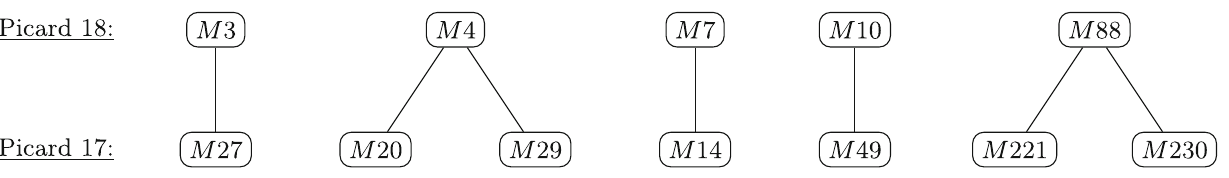
Fig. 5 Links between polytopes with Picard 18 and 17. Going from Picard 17 to 18 amounts to removing a point the in the polytope in the M lattice (i.e. a monomial in the hypersurface equation which defines the K3